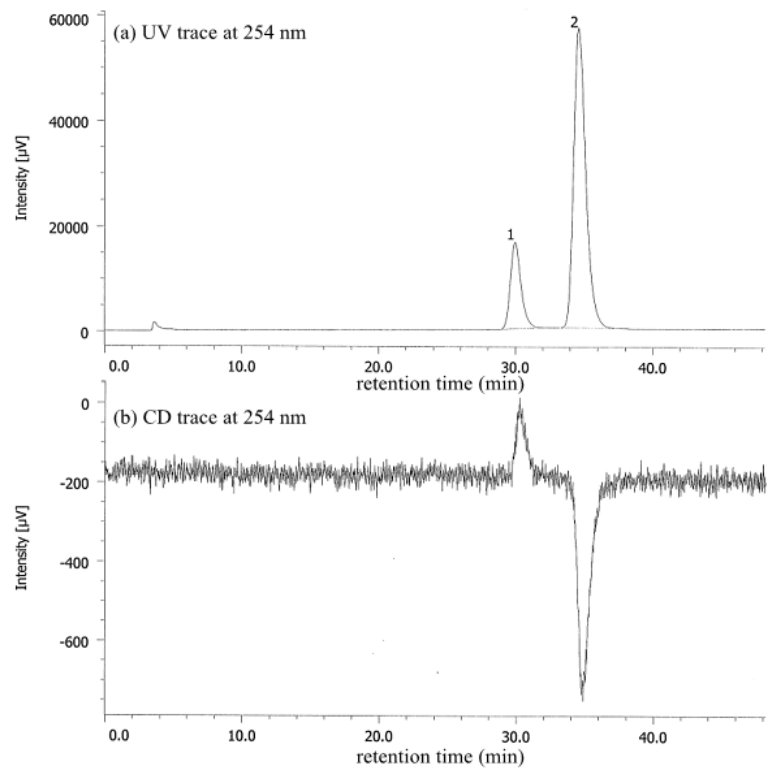
Figure 4. HPLC analysis of 1c (60% ee ) after removal of DBTA from the chiral salt by extraction: Daicel CHIRALPAK ® AD-H, 0.46 cm ø × 25 cm, UV 254 nm, t t = 34.6 min (hexane:EtOH = 95:5, 0.9 mL/min, 0 R(2)